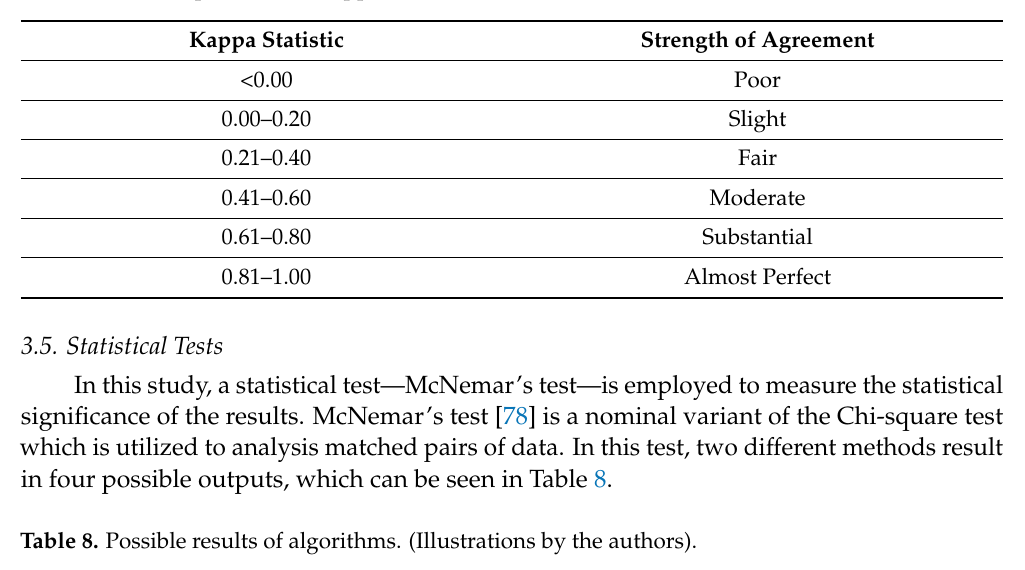
Table 7. The interpretation of Kappa values [77].